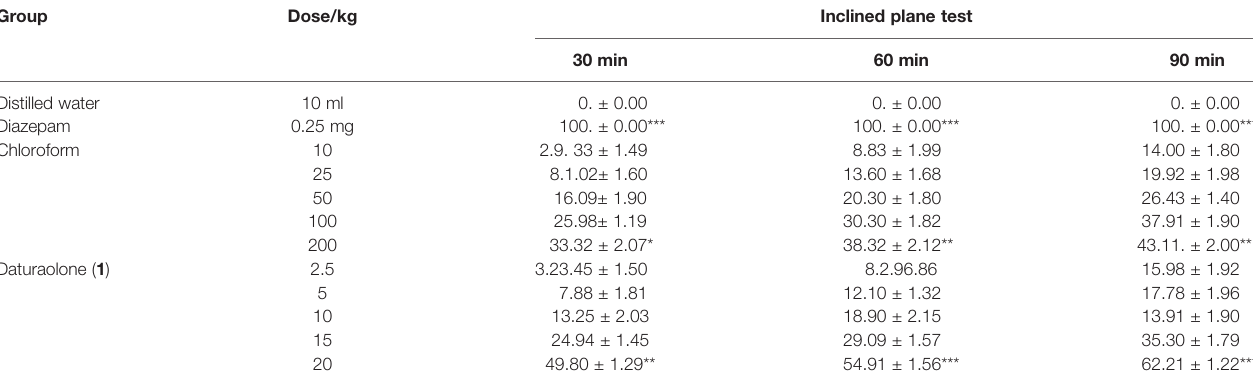
The data of muscle relaxant effect represented the % activity of mice (n = 6) in both models, at 30, 60, and 90 min after administration of samples. The data is represented as the mean ± SEM (n = 6); *p < 0.05, **p < 0.0.01, ***p < 0.001; all values as related with control.